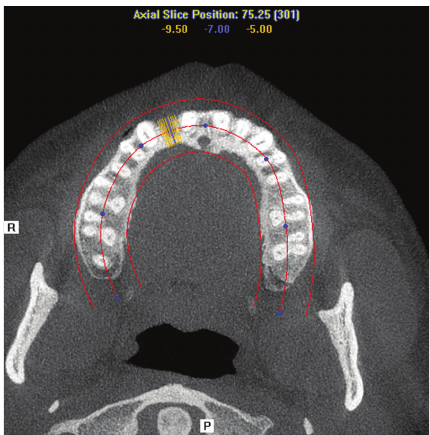
Figure 3: Preoperative axial section on CBCT. Decreased labio- palatal thickness of edentulous area may be noted.